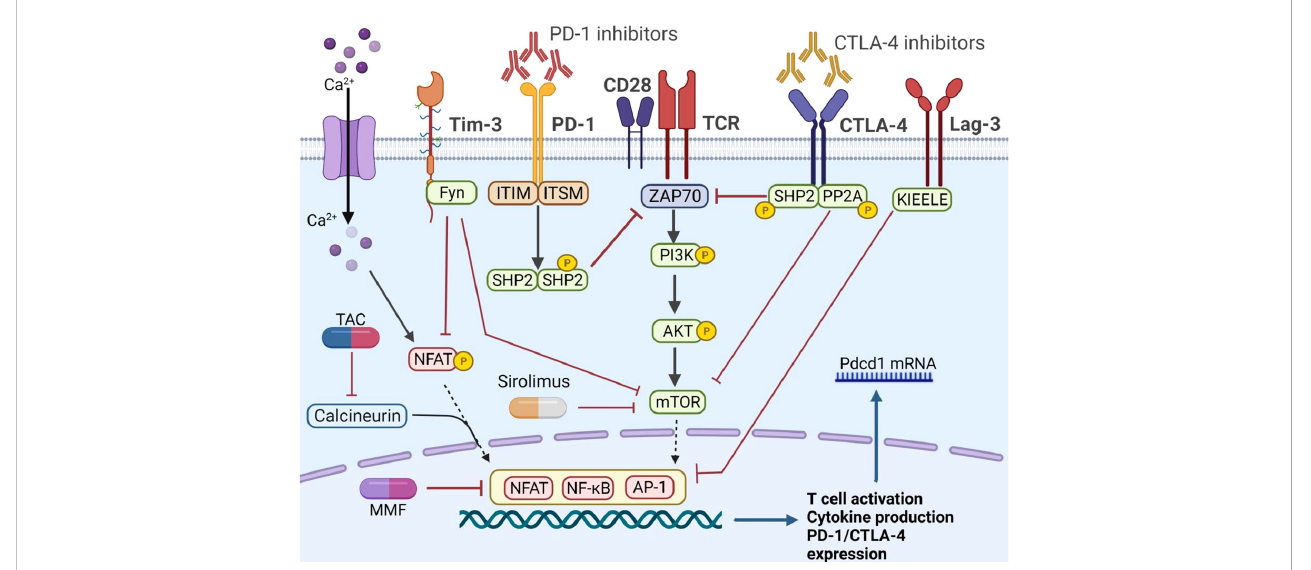
FIGURE 2 The co-stimulatory and co-inhibitory pathways in T cells. The PD-1 axis could phosphorylate ITIM and ITSM, recruit SHP1 and SHP2, and further inhibit ZAP 70. Similarly, CTLA-4 pathway recruited SHP2 and PP2A, and attenuated the mTOR signaling. Fyn is another motif on the cytoplasmic tail of Tim-3, promoting the inhibitory function by inhibiting the NFAT and mTOR activity. The unique KIEELE motif is essential for the inhibitory function of Lag-3. When implemented with ICIs, the co-inhibitory pathway is inhibited and T cell is activated. Immunosuppressive agents, such as CNIs and mTOR inhibitors, can obstruct T cell activation by different mechanisms. PD-1, programmed cell death protein-1; PD-L1, programmed cell death ligand 1; CTLA-4, cytotoxic T lymphocyte antigen 4; PP2A, protein phosphatase 2A; ITIM, immune-receptor tyrosine based inhibitory motif; ITSM, immune- receptor tyrosine based switch motif; ZAP 70, zeta-chain-associated protein kinase 70; SHP, src homology 2 domain- containing protein tyrosine phosphatase; NFAT, nuclear factor of activated T cells; mTOR, mammalian target of rapamycin; Tim-3, T cell immunoglobulin-3; Lag-3, lymphocyte activation gene-3; TIGIT, T cell immunoglobulin and ITIM domain; TAC,